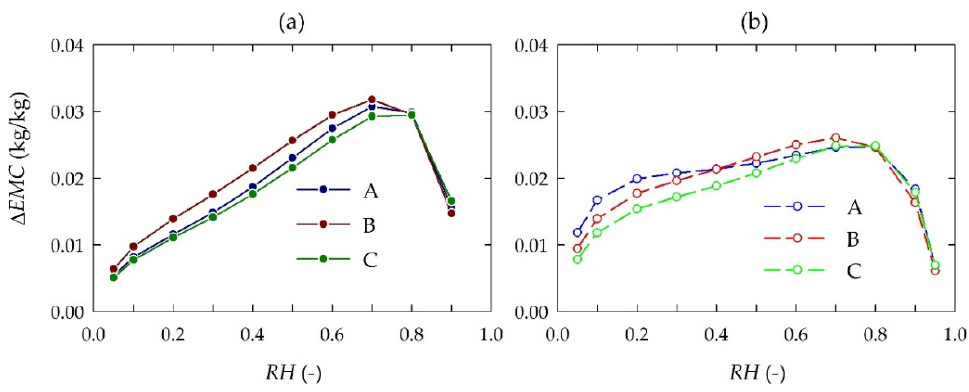
Table 4. Coefficient coefficients of the sorption GDW model for lime ( Tilia cordata Mill.) bark and wood.